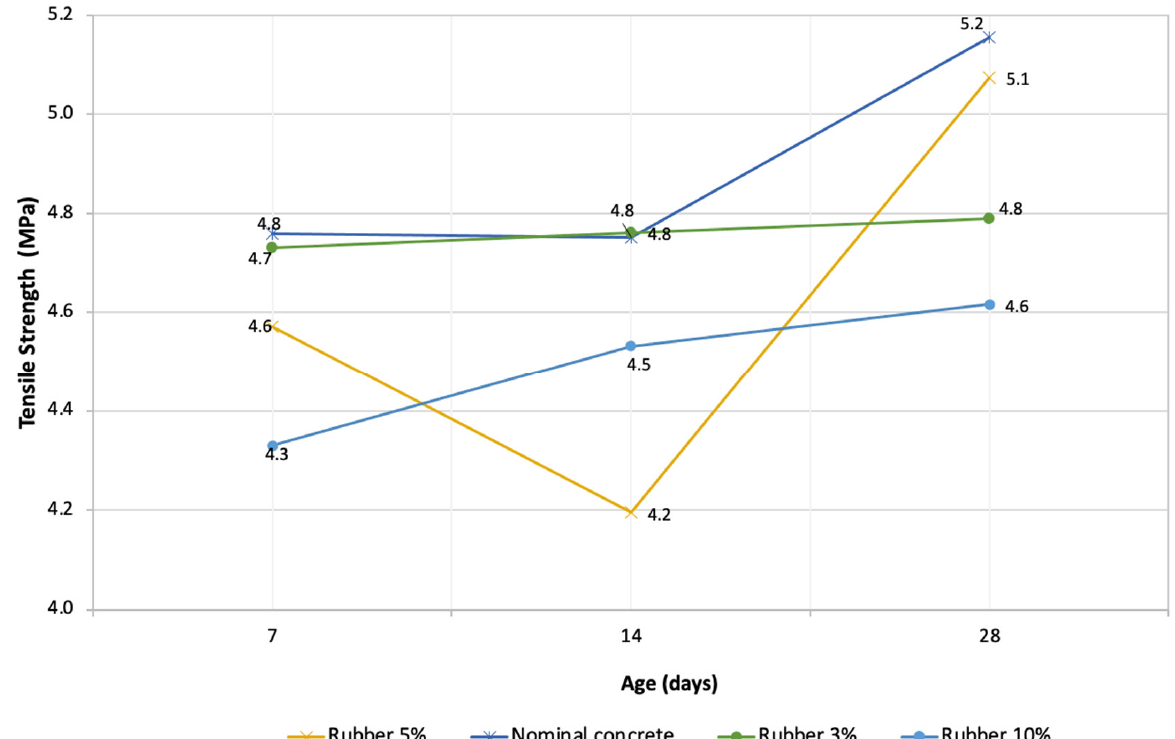
Figure 5. Tensile strengths at the ages of 7, 14, and 28 days.